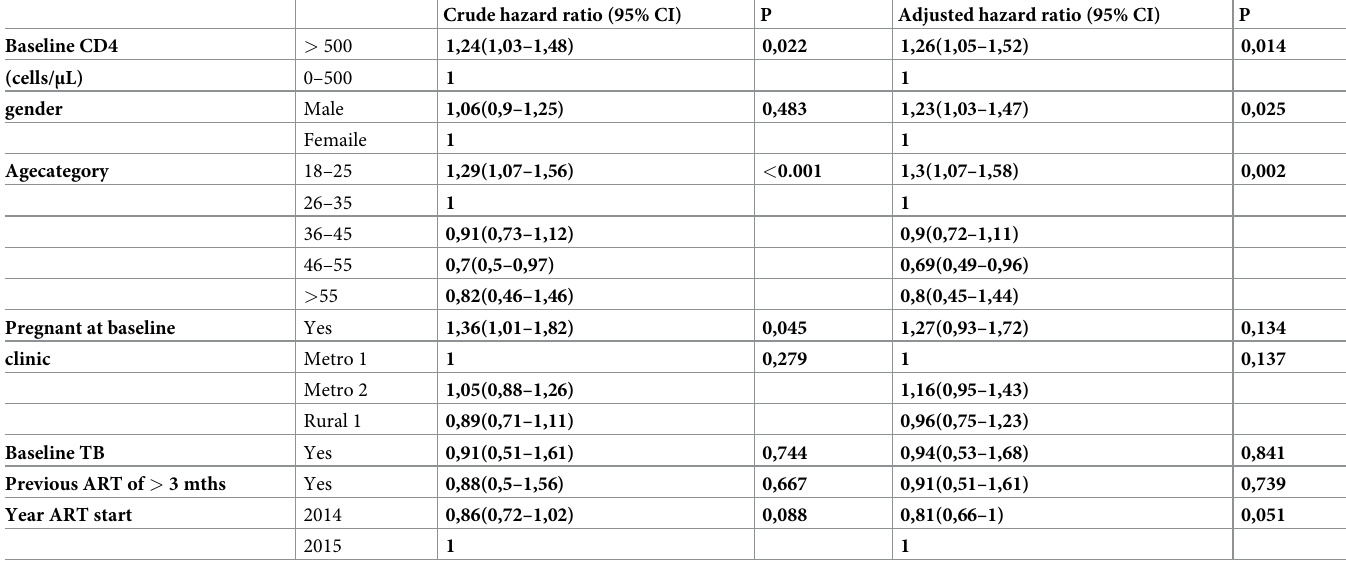
Table 3. Cox regression modelling of baseline characteristics and attrition comparing baseline CD4 categories > 500 cells/ μ L and 0–500 cells/ μ